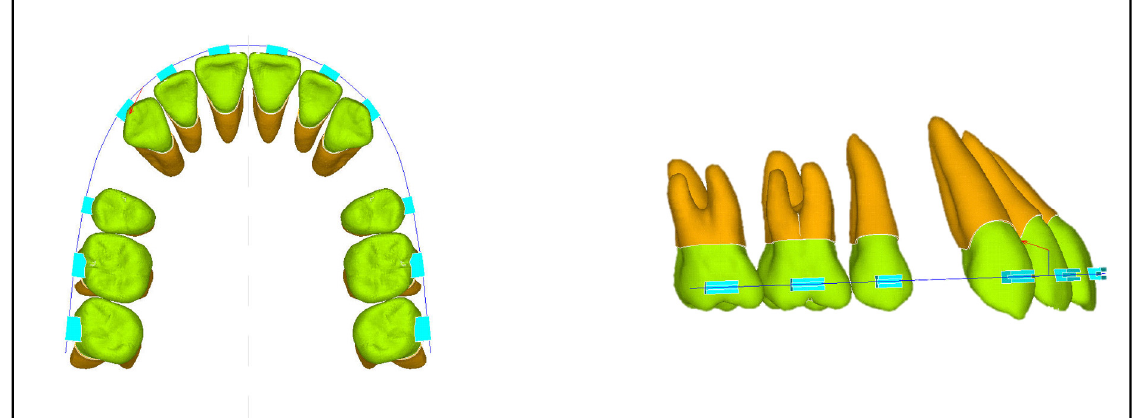
Figure 1. Finite element modeling of teeth, brackets, and archwire.